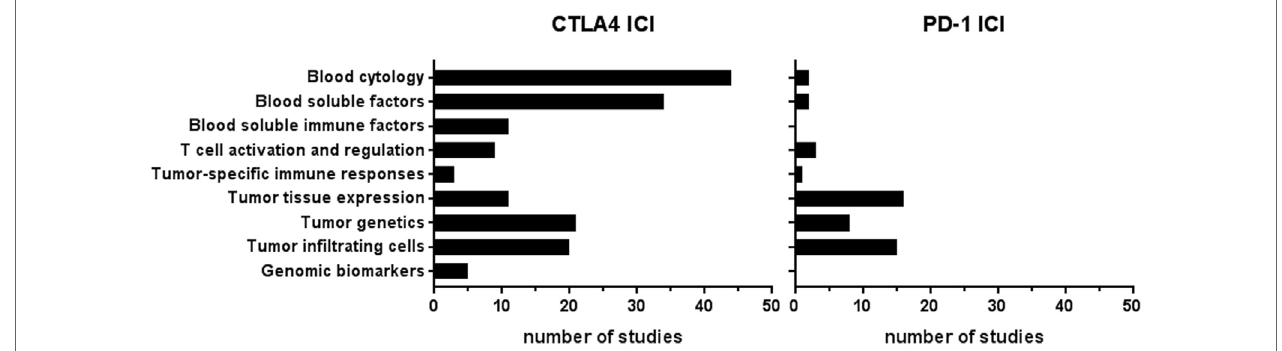
FiGURe 2 | Number of studies per biomarker